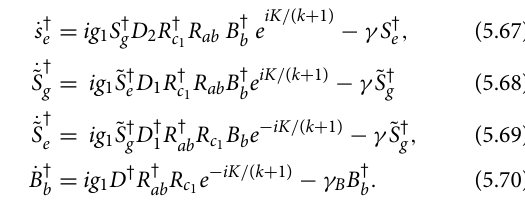
0 , the coupling constants are constant: g 1 =